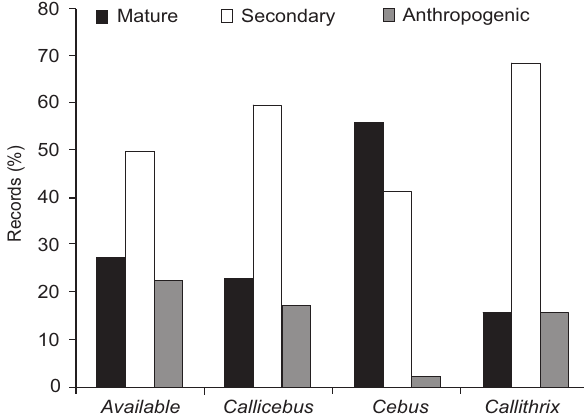
Figure 5. Habitat availability and use by each primate species dur- ing surveys at the Fazenda